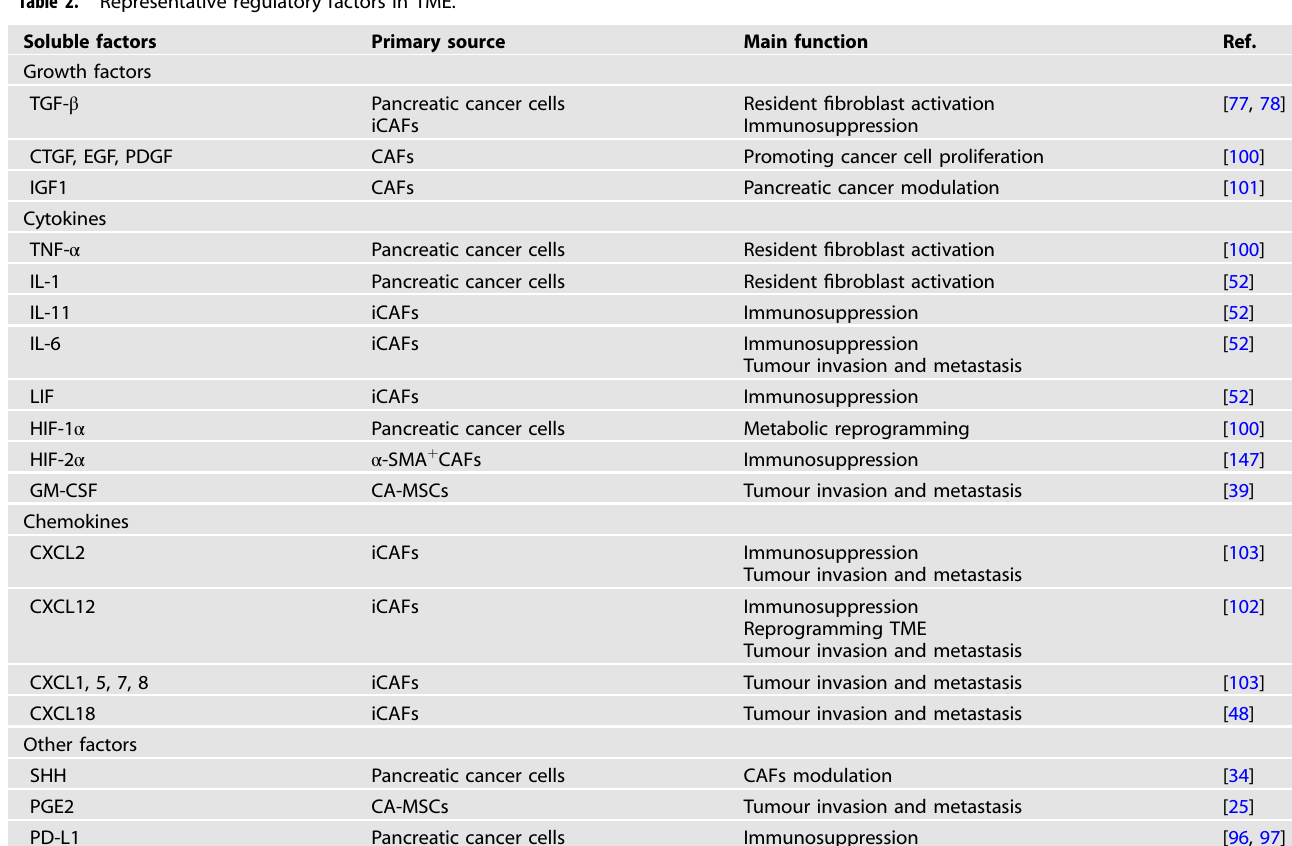
Table 2. Representative regulatory factors in TME.